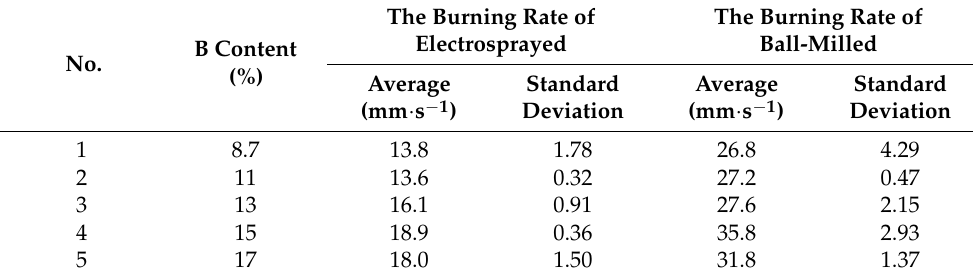
Table 2. The burning rate of the B/NC/CuO thermite device.